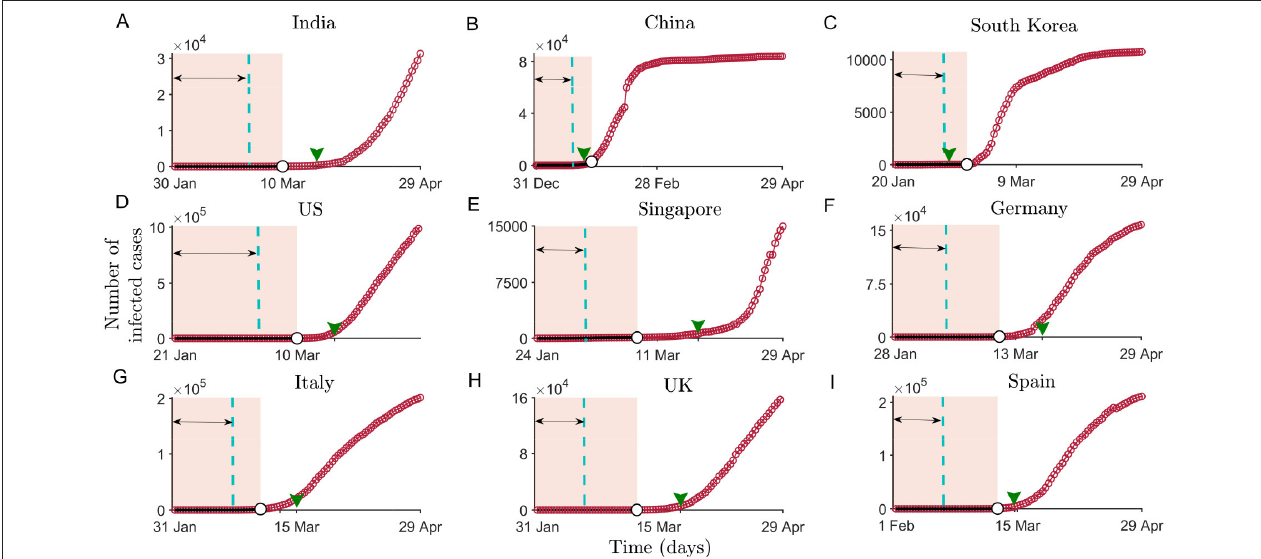
FIGURE 1 | Time series constructed as cumulative number of infected cases in nine different countries across the world from the onset of the epidemic in the respective countries up to April 29. (A-I) : Shaded regions depict the pre-transition phase for different countries from the onset and mark the data used to compute the indicators of critical slowing down. The double-sided arrow marks the size of the moving window (up to the vertical dashed line). In the subfigures, the arrowhead on the x -axis marks the beginning of the officially recorded social-distancing and/or lockdown dates (see Table S1 in Supplementary Material